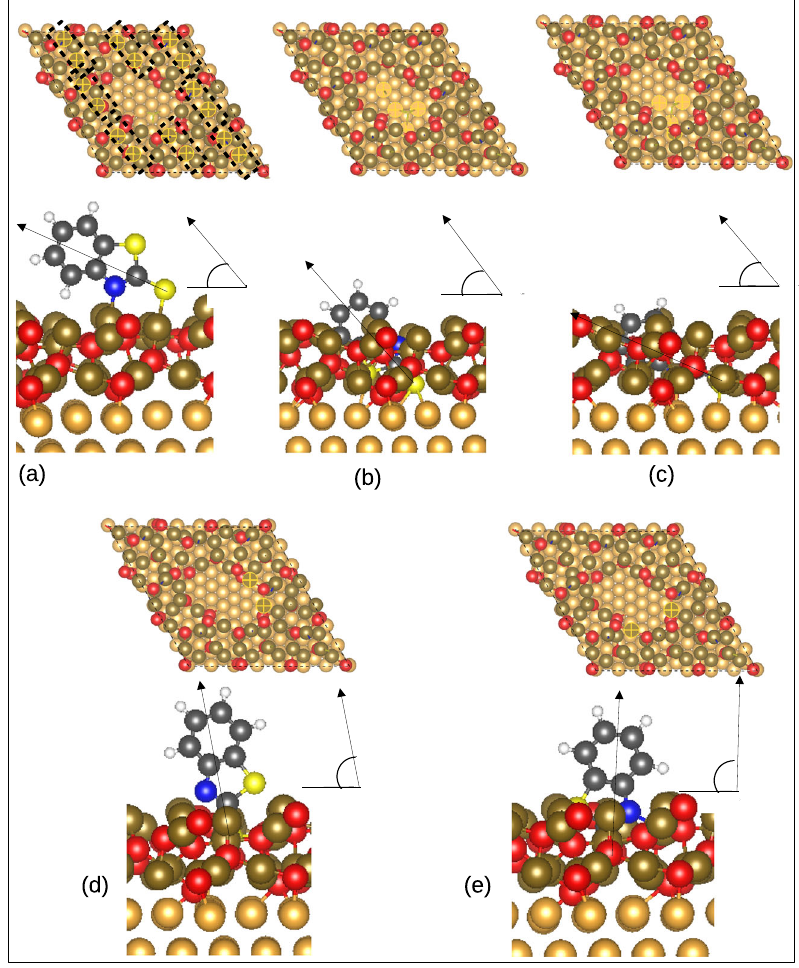
Fig. 7 Different snapshots of MBT° adsorbed on different parts of partially oxide-covered copper surface. a Illustrates the adsorption on the oxide surface and oxide edges, b and c on the metal surface (con fi gurations 1 and 2), and d and e on the oxide walls (con fi gurations 3 and 4).